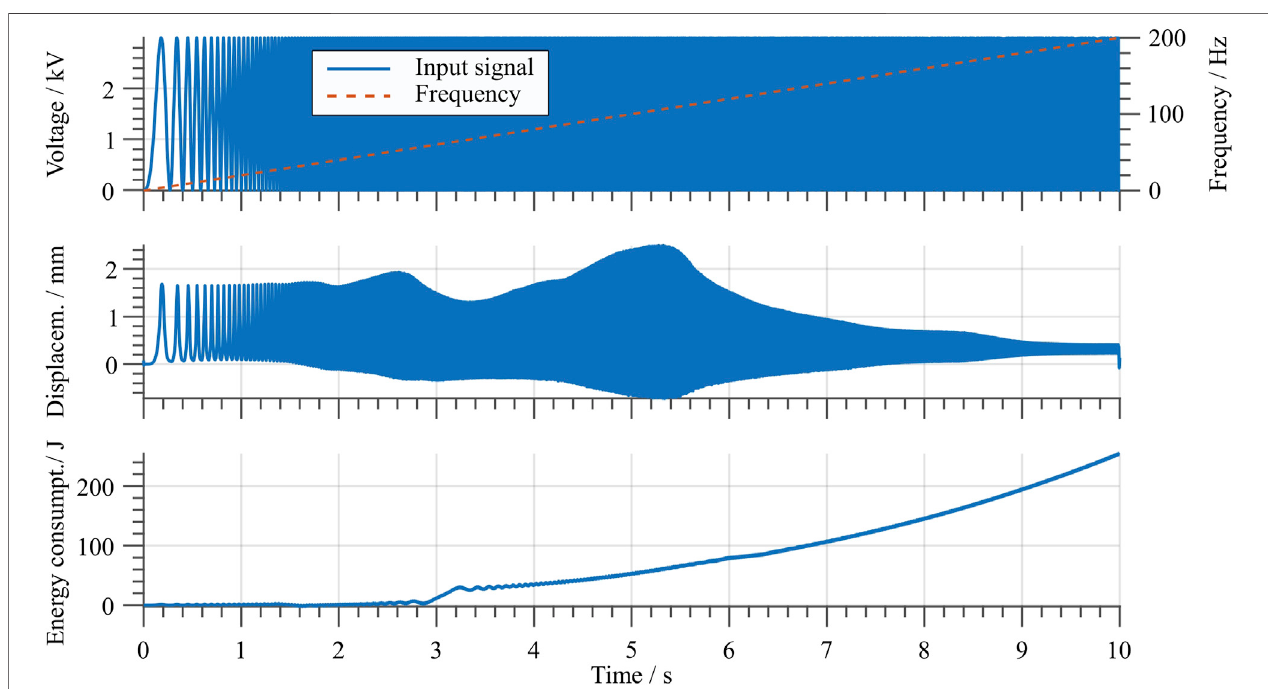
FIGURE 13 | Stroke and energy consumption with a sine sweep input signal. The top graph shows the input signal in blue and the frequency over time with a dashed red line.